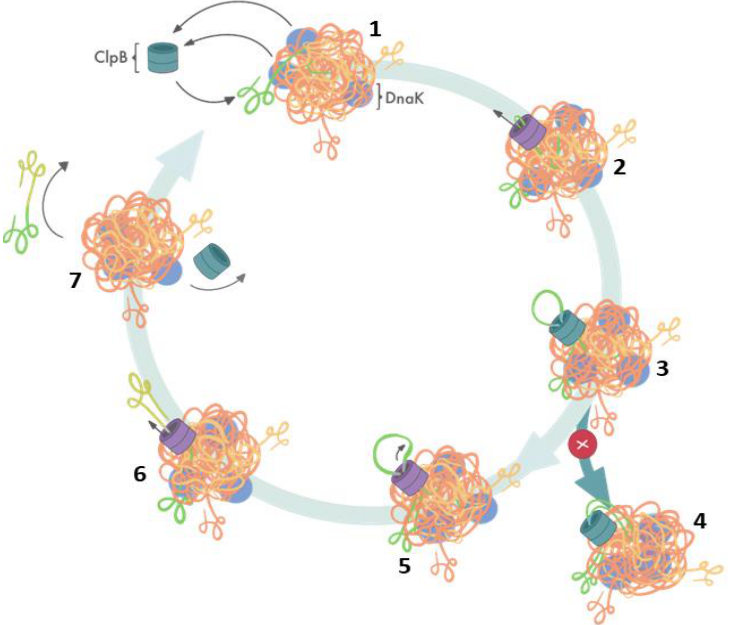
Figure 2. Cooperation of ClpB and DnaK during aggregate reactivation based on ref. [35]. (1) The aggregate-bound DnaK recruits ClpB to a protein aggregate and exposes ClpB-accessible fragments of the aggregate; (2) ClpB initiates substrate translocation from an exposed polypeptide loop; (3) stably folded domains can become obstacles for ClpB-mediated polypeptide extraction; (4) resistance during the translocation stalls ClpB-mediated disaggregation; (5) switching to single-strand translocation can release stalled ClpB; (6) extracted unfolded polypeptide exits the ClpB channel; (7) extracted polypeptide refolds while ClpB can engage in another polypeptide extraction cycle.